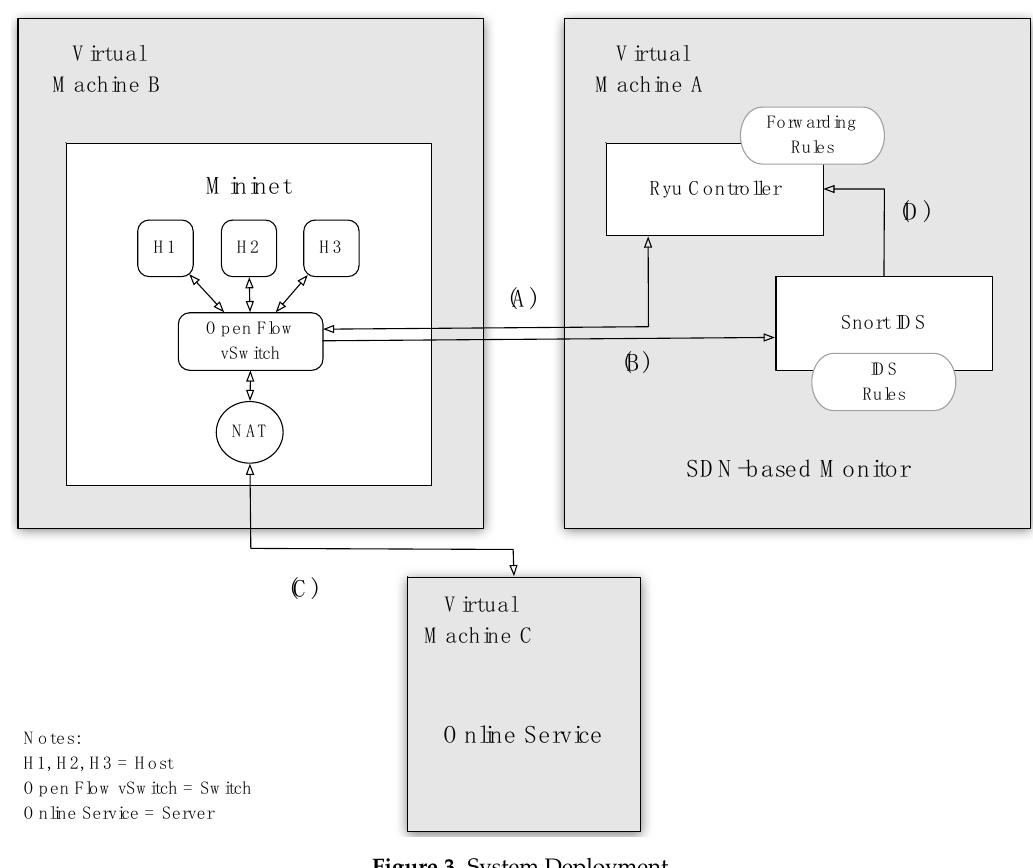
Figure 3. System Figure 3. System Deployment.